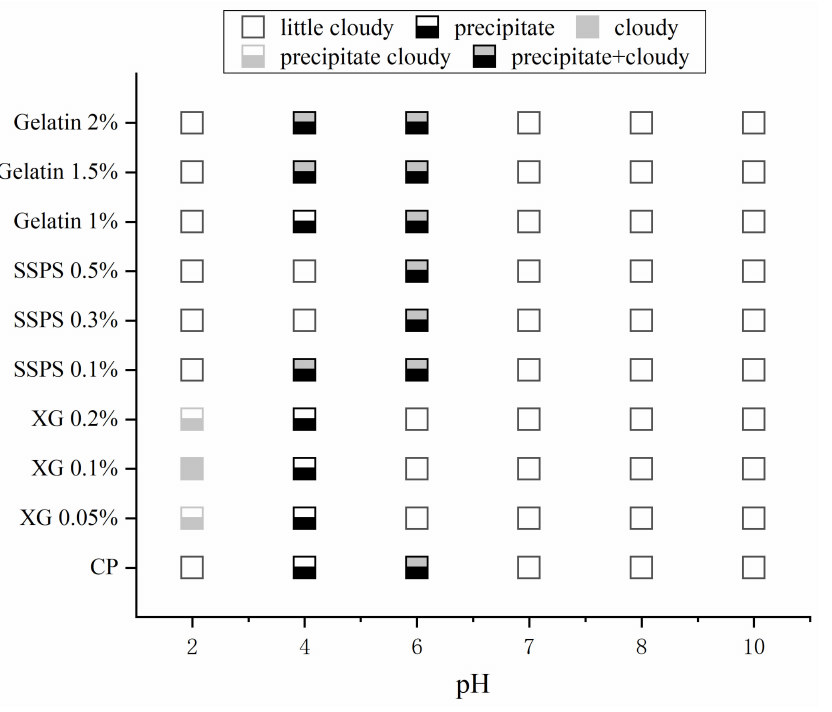
Figure 1. State diagrams of CP-Hydrocolloid systems at different pH values and different concen- tration of the three hydrocolloids (CP-Coconut protein, XG-Xanthan gum, SSPS-Soluble soybean